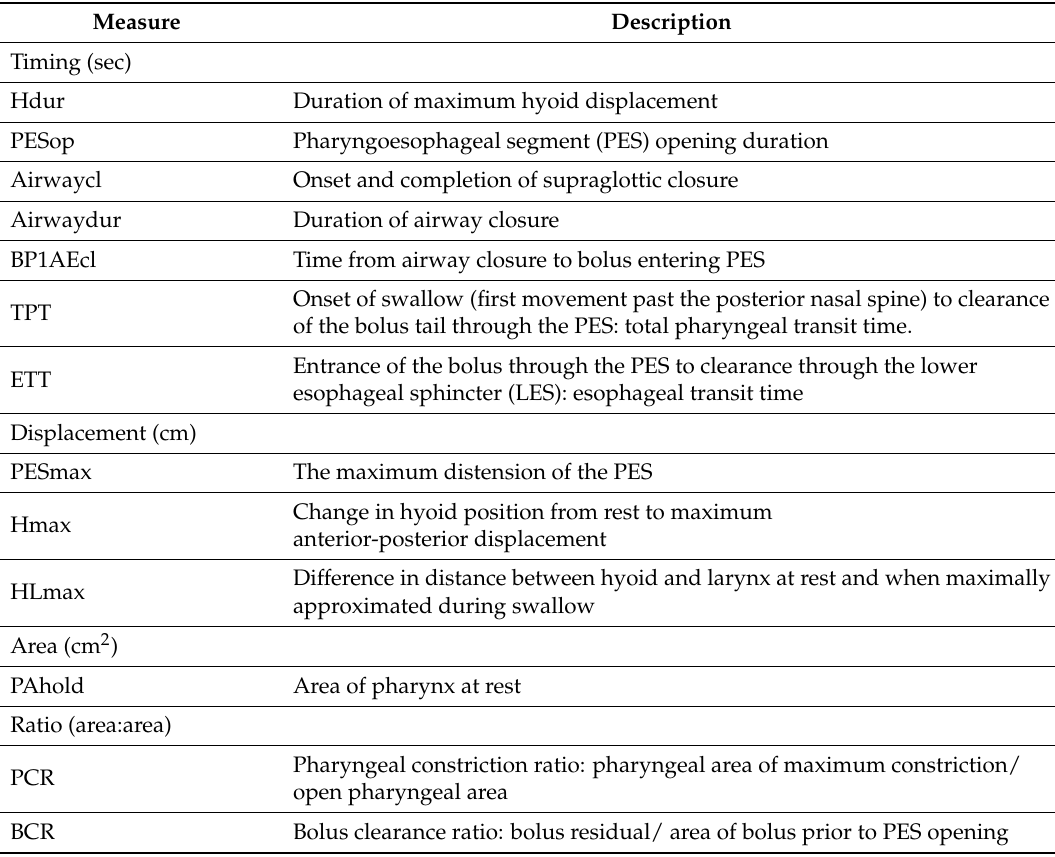
Table 1. Quantitative swallowing measures of timing, displacement, and area